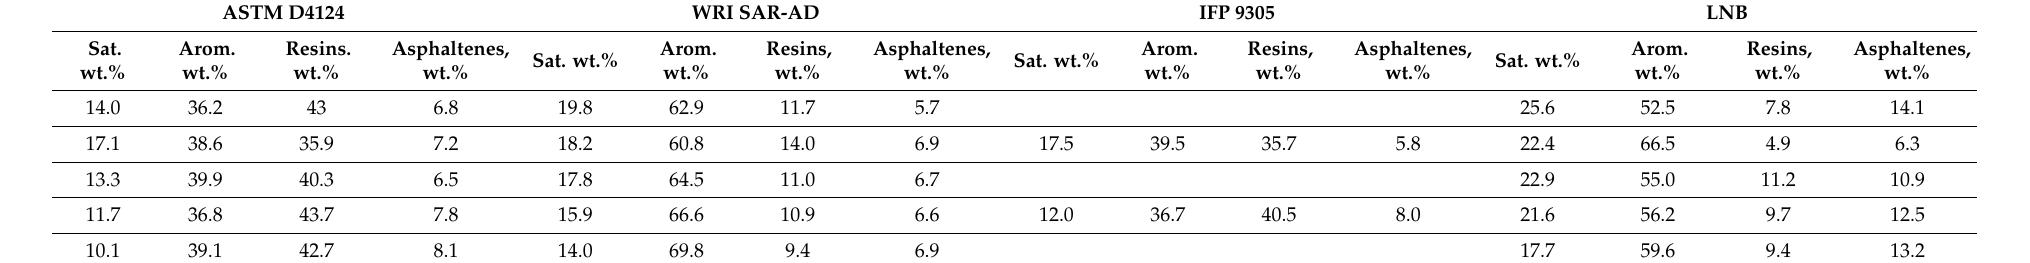
Table 2. SARA composition data of straight run vacuum residues measured by ASTM D4124, SAR-AD TM , IFP 9305, and LNB Research Laboratory methods. ASTM D4124